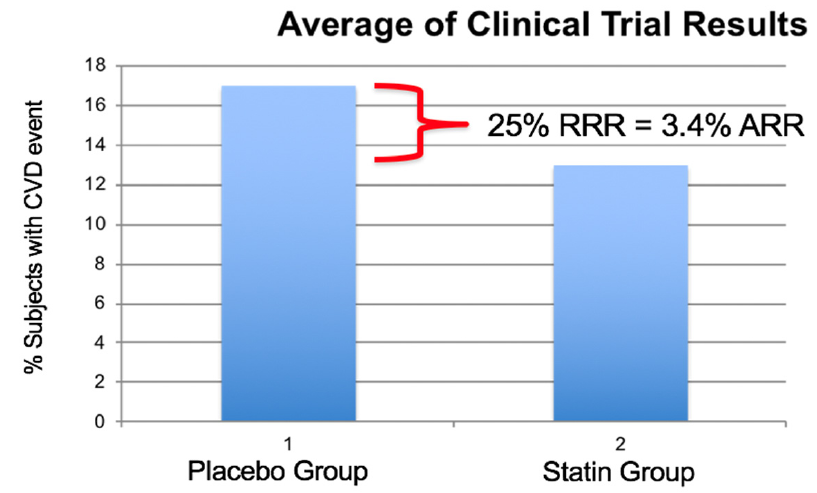
Figure 1. Percent of subjects experiencing a cardiovascular event in eight large statin investigations Scandinavian Simvastatin Survival Study (SSSS), Pravastatin or Atorvastatin Evaluation and Infection Therapy–Thrombolysis in Myocardial Infarction 22 (PROVE-IT 22), Heart Protection Study (HPS), Long-Term Intervention with Pravastatin in Ischaemic Disease (LIPID), Cholesterol and Recurrent Events (CARE), Treating to New Targets (TNT), Air Force/Texas Coronary Atherosclerosis Prevention Study (AFTEXCAPS), West of Scotland Coronary Prevention Study (WOSCOPS). Average relative risk reduction was 25% and the absolute risk reduction was 3.4% illustrating the large number of subjects experiencing a cardiovascular (CV) event while on statin therapy with reduced LDL-C values. (Modified from reference